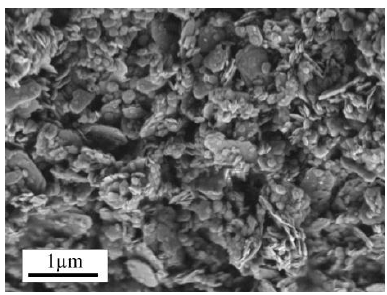
Figure 3. SEM image of the metakaolin